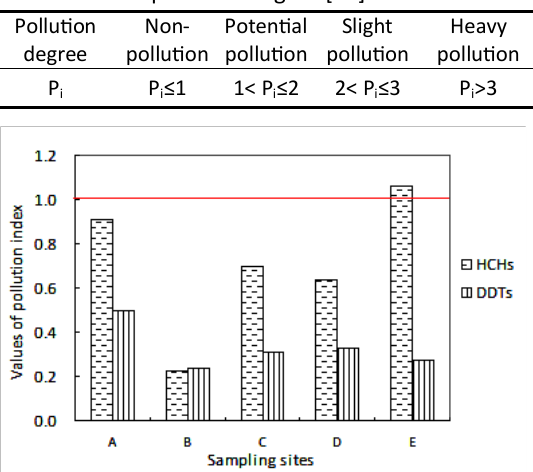
Table 3. The value of single pollution index and